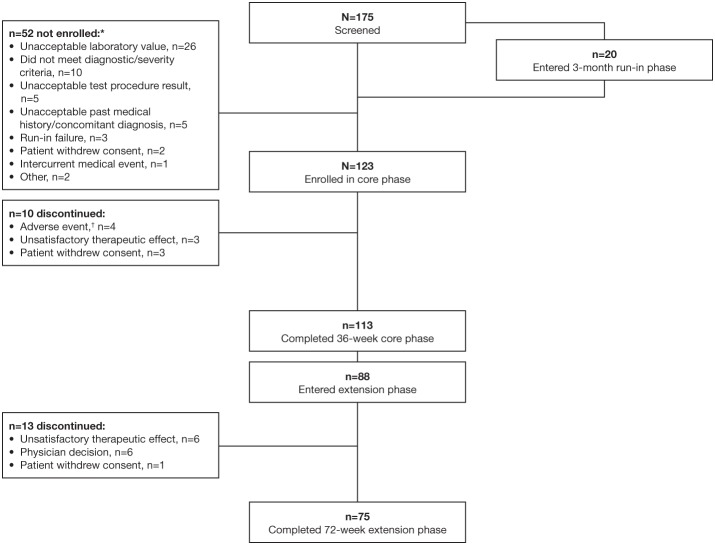
Patient disposition. *More than one reason for screening failure could be specified for each patient; †Hyperglycemia (n = 3), ketoacidosis (n = 1), stress cardiomyopathy (n = 1).